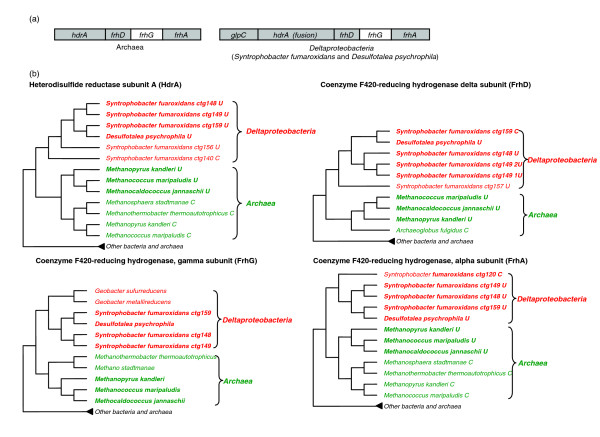
Organization and phylogenetic analysis of components of the archaeal four-gene and bacterial five-gene operons. (a) Organization of operons in archaea and bacteria. Selenoprotein genes are shaded. (b) Phylograms of different proteins in these operons. Red indicates Deltaproteobacteria, and green indicates Archaea. Organisms containing the four-gene or five-gene operon are shown in bold. The branch separating other archaea and bacteria in the trees has been shortened for illustration purposes. C, Cys-containing; FrhA, coenzyme F420-reducing hydrogenase α subunit; FrhD, coenzyme F420-reducing hydrogenase δ subunit; FrhG, coenzyme F420-reducing hydrogenase γ subunit; GlpC, Fe-S oxidoreductase; HdrA, heterodisulfide reductase subunit A; U, Sec-containing.